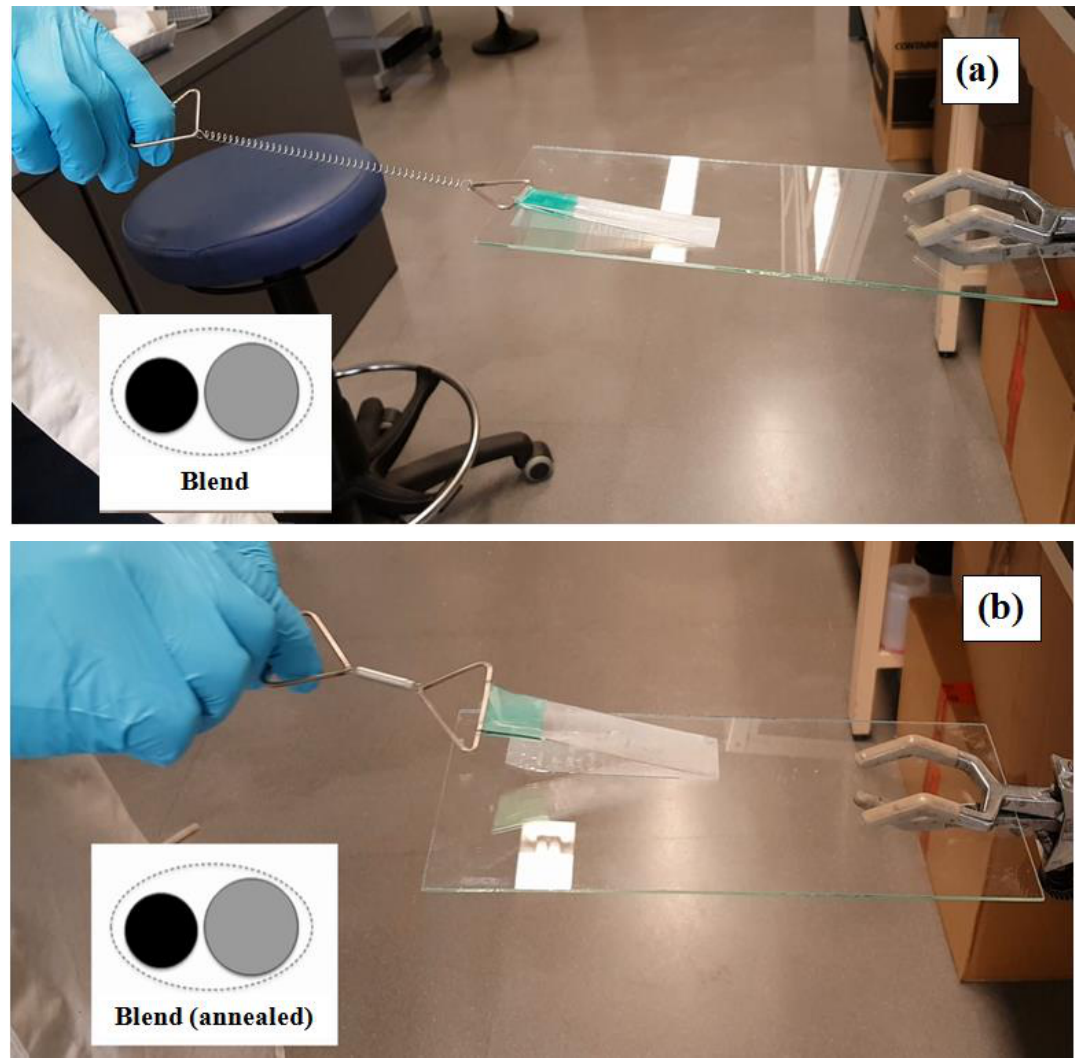
Figure 6. Effect of annealing on peeling for Blend 5. ( a ) Untreated bonded adhesive and ( b ) bonded adhesive annealed 10 min at 60 °C and cooled down.